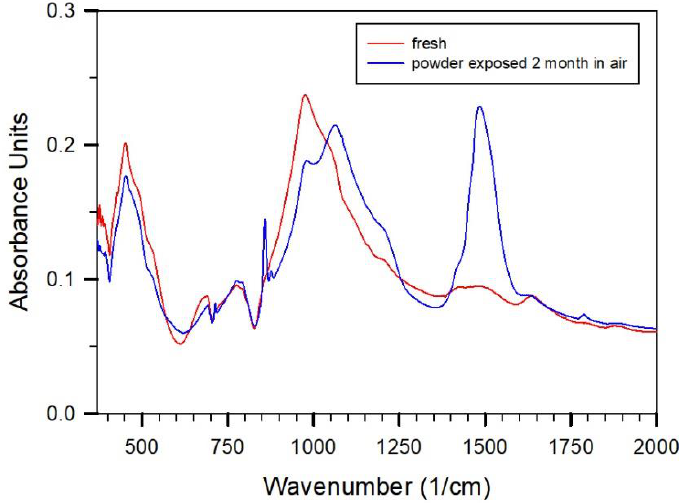
Figure 2. Absorption spectra of fresh lime-sand brick probed from the core (shown in Figure 1) and of powder from the core exposed for two months under open conditions. In both spectra the Qz-contribution is subtracted.